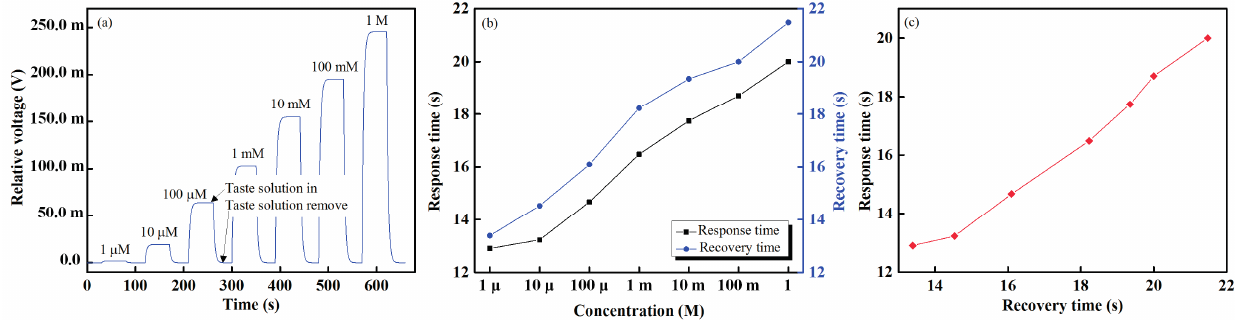
Figure 10. Performance of the proposed sensing system for different taste solutions: ( a ) sensitivity; and ( b ) linearity.